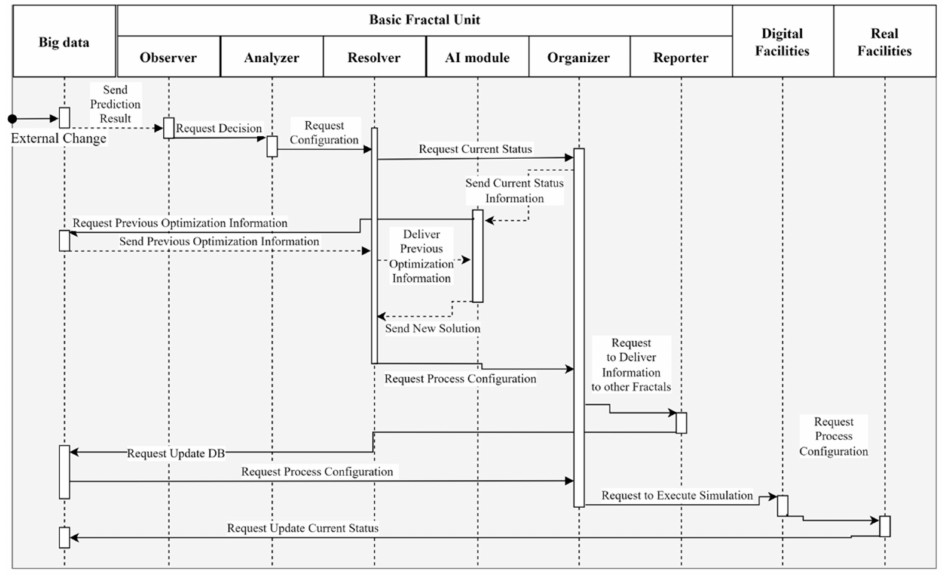
Figure 12. Sequence diagram of reconfiguration flow in